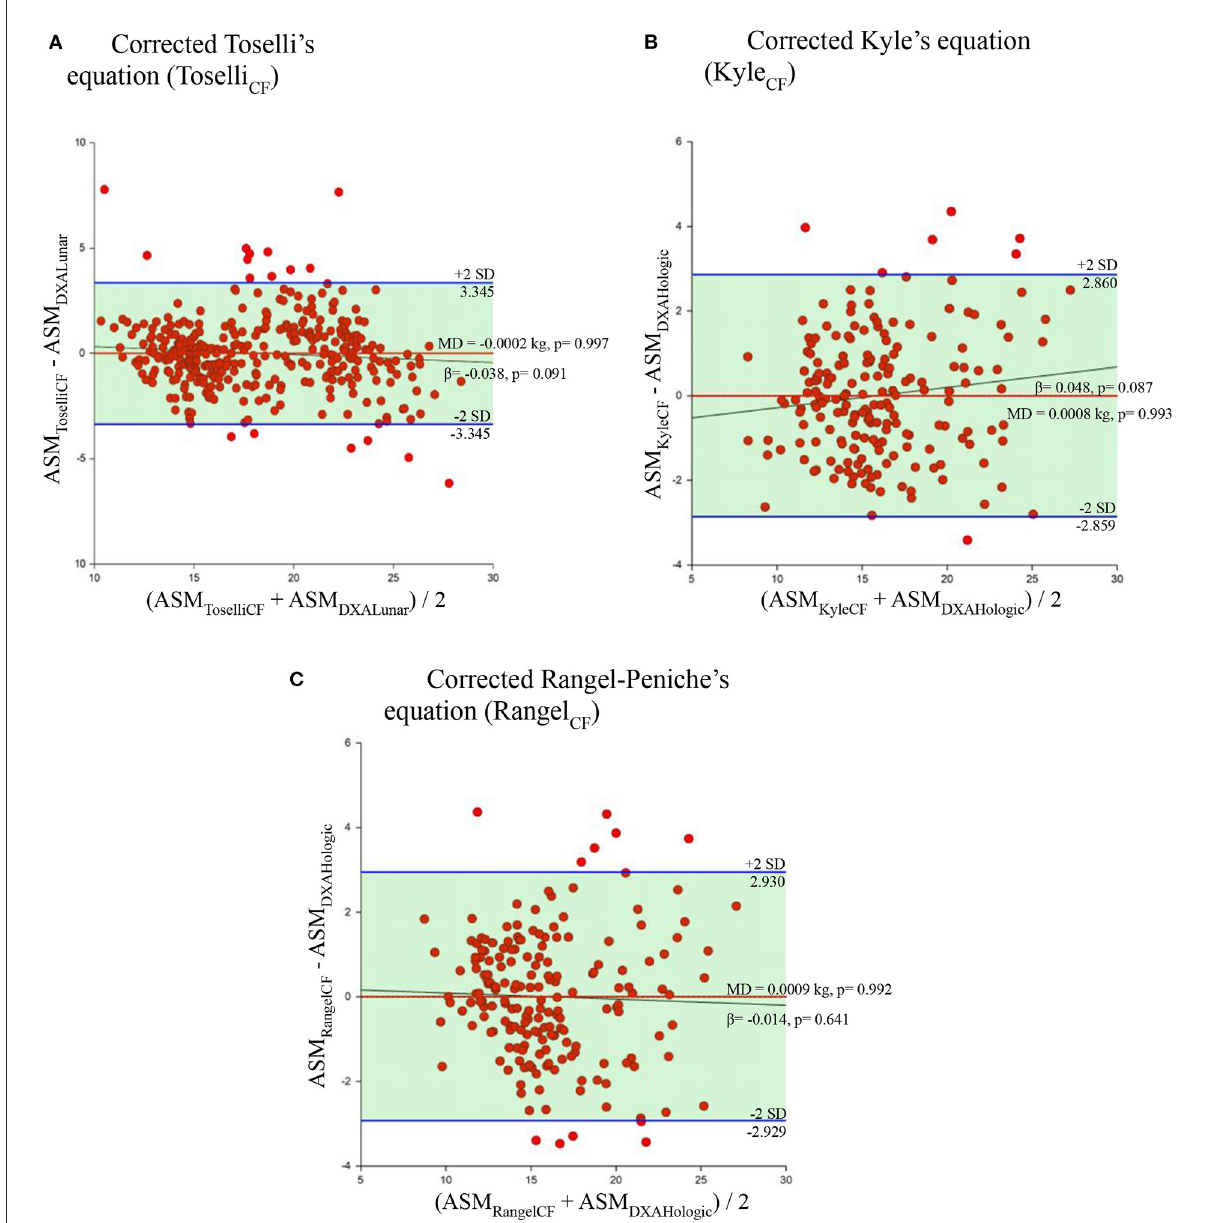
FIGURE3 Bland and Altman plots and simple linear regression of the selected equations applying the correction factors. Behavior of the mean difference against the mean of the measurements between the corrected equations and their respective reference method. Solid red line indicates the mean difference. Solid blue line indicates the limits of agreement. Solid black line indicates the regression line. Dotted line indicates zero. ASM, appendicular skeletal muscle mass. MD, mean of the differences. (A) Corrected Toselli’s equation (Toselli CF ). (B) Corrected Kyle’s equation (Kyle CF ). (C) Corrected Rangel-Peniche’s equation (Rangel CF